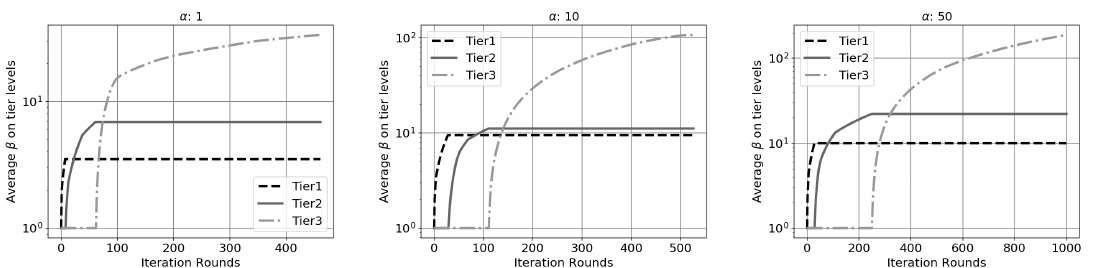
Figure 5. Middleman price β values by tier in the case of various peering cost α values in a balanced tree-like topology